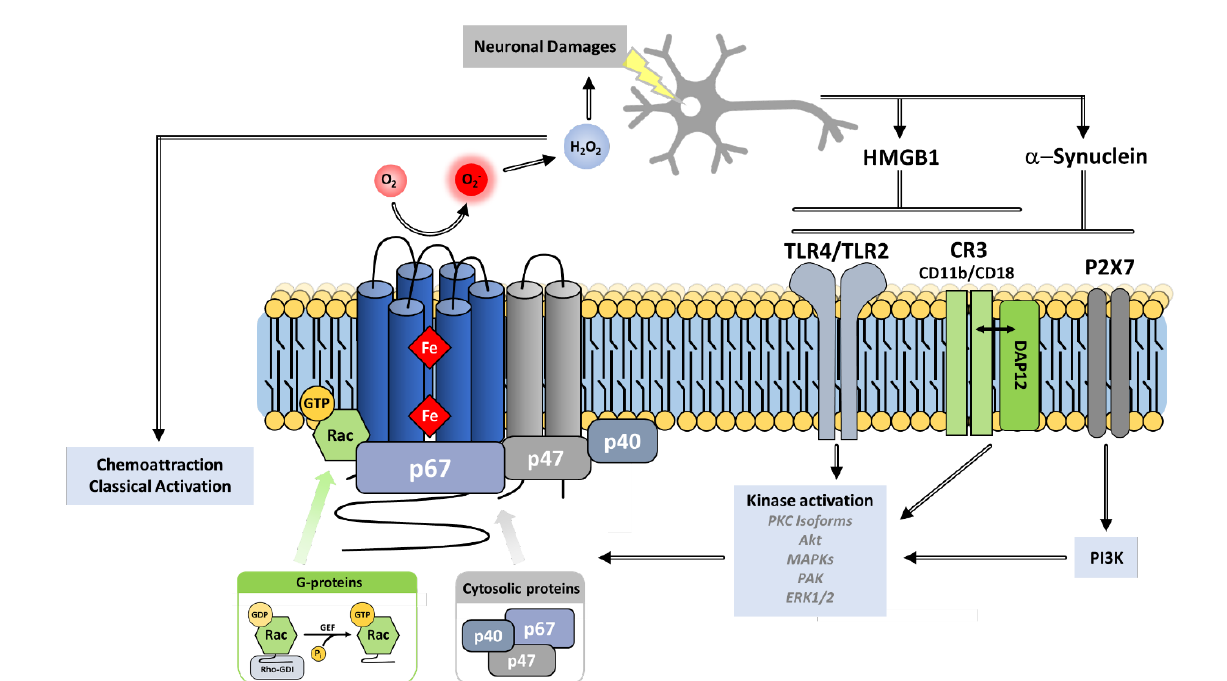
Figure 18. Activation mechanism of microglial NOX2 involved in Parkinson’s disease. a-Synuclein-induced micro-glia activation may involve different surface receptors such as P2X7, TLR2/4 and CR3 that activate kinases, leading to phosphorylation of p47 phox and NOX2 activation. Subsequent ROS production leads to migroglial chemoattraction and oxidative stress. Resulting neuronal damage then further activates the release of the protein (HMGB1) and synuclein. Figure is adapted from [366].